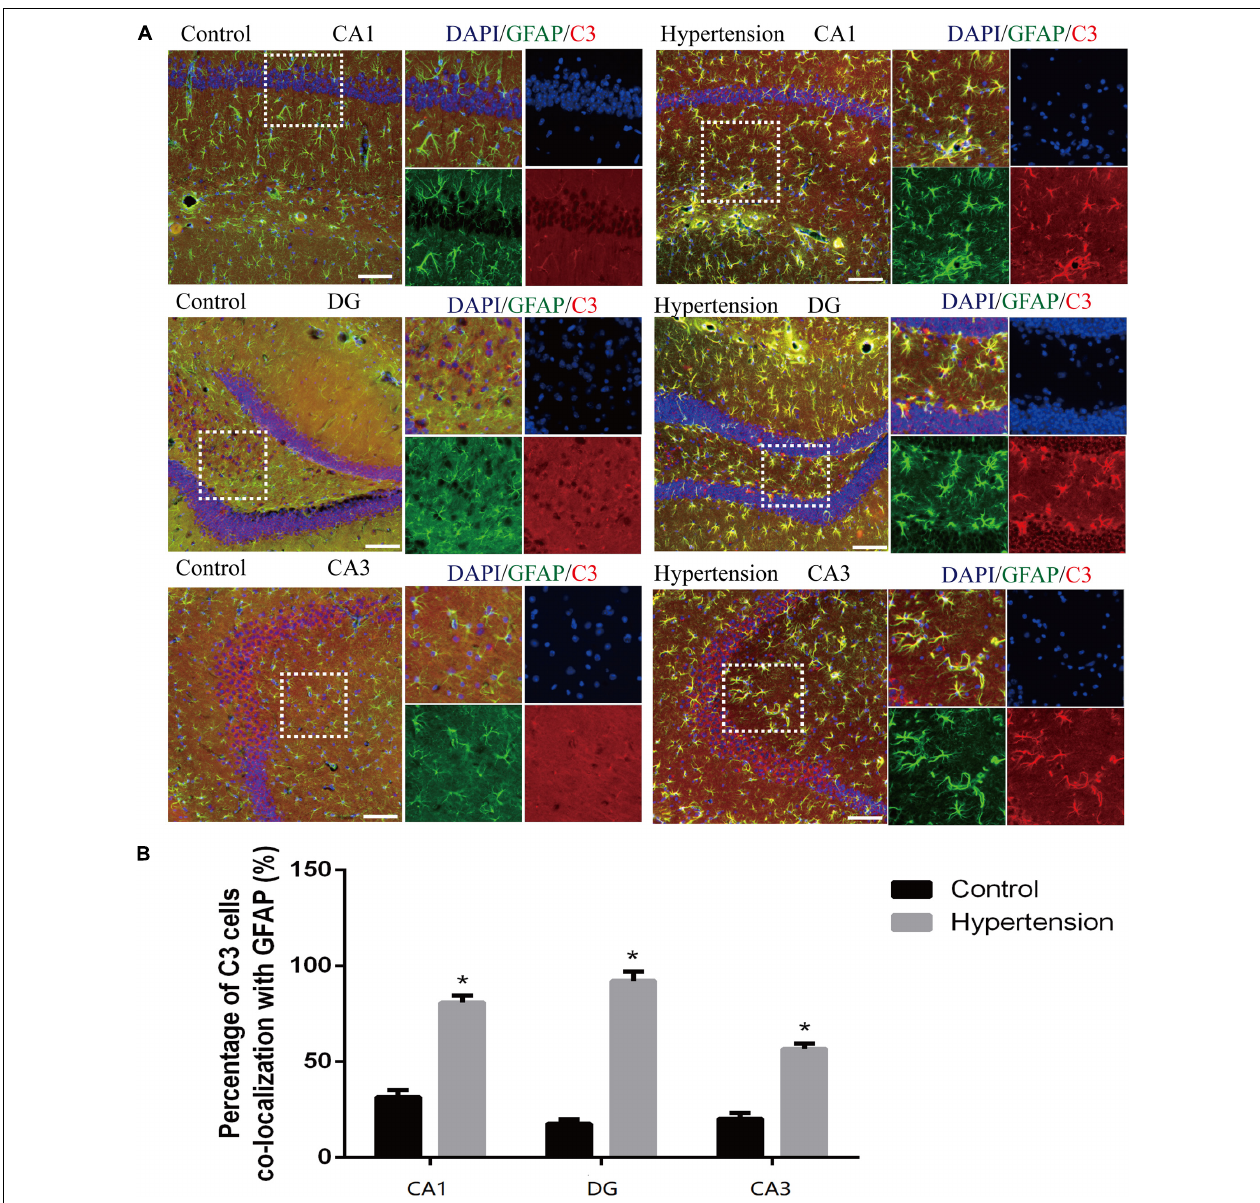
FIGURE 5 | Astrogliosis and notable reactive A1 astrocytes were found in the hippocampus of middle-aged mice after 30 days of angiotensin II treatment. (A) Representative images of immunofluorescence double staining with the anti-GFAP (green) and anti-C3 antibodies (red) in the hippocampus (CA1, DG, and CA3) of the mice in the control and hypertension groups (immunofluorescence, × 20, scale bar = 100 µ m). (B) Histograms comparing C3 levels of astrocytes in the hippocampus (CA1, DG, and CA3) of the mice in the control and hypertension groups. Data are expressed as the means ± SD. * p < 0.05.